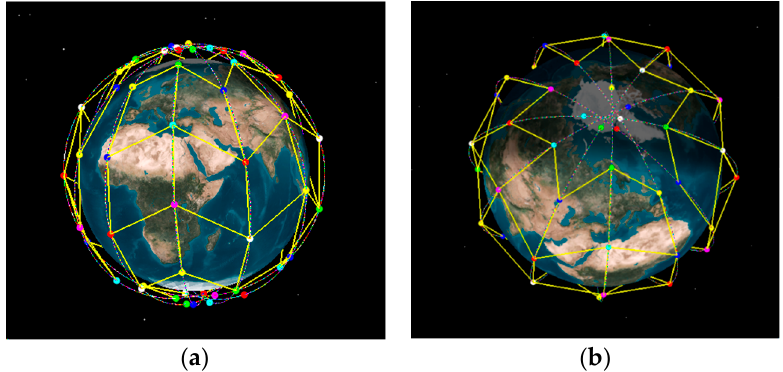
Figure 1. Satellite networks topology, (a) Equatorial region (b) Polar region